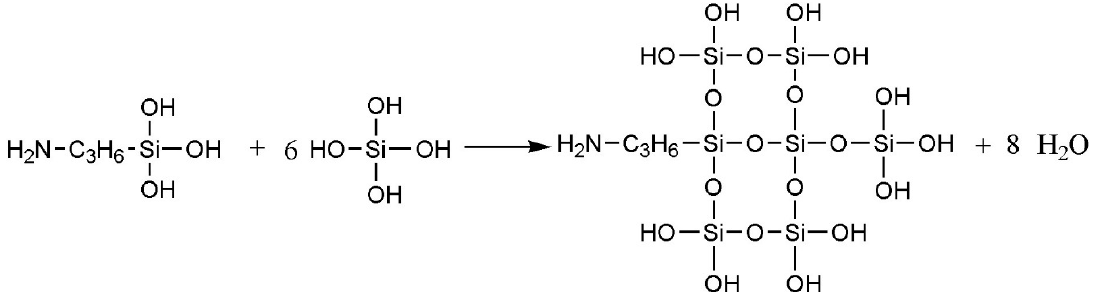
Figure 1. Interaction between TEOS and KH550.